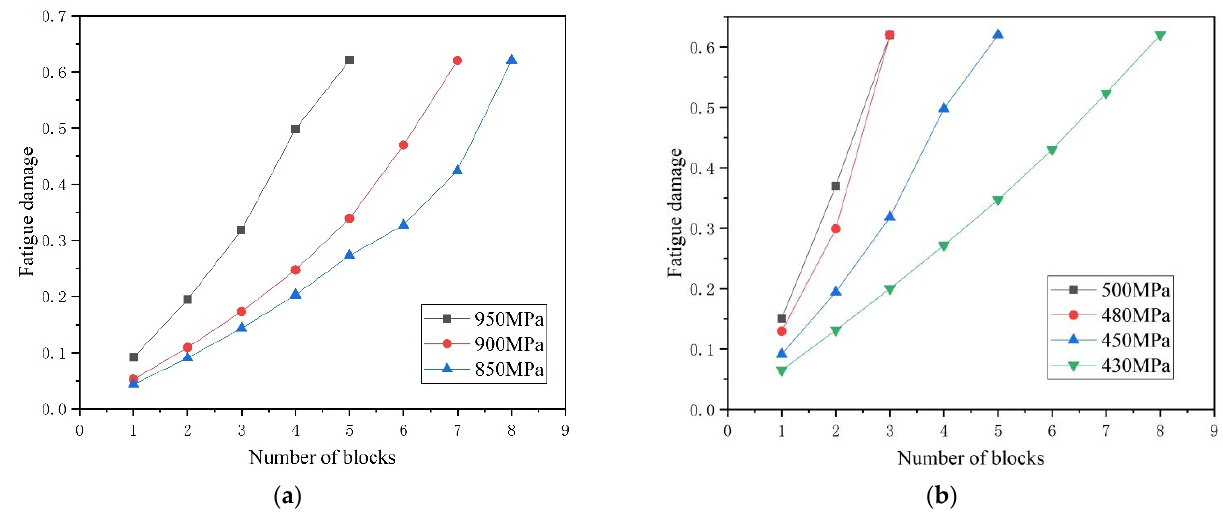
Figure 7. Comparison of the prediction of cumulative life and experimental data for the stress block with the second level of 2 × 10 5 cycles.